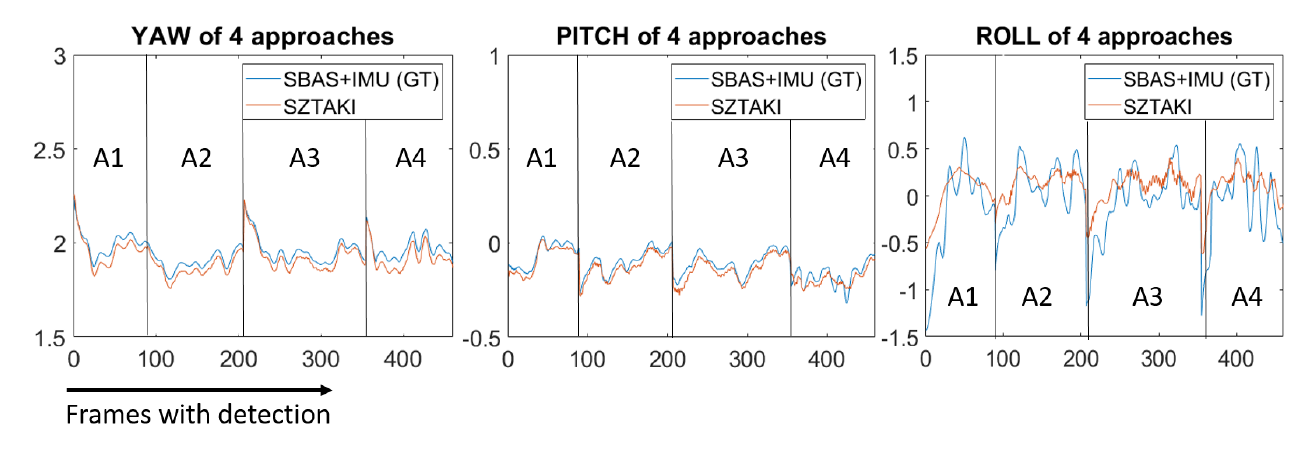
Figure 14. Septfonds euler angle measurements. Approaches have different duration, frames are captured at 10